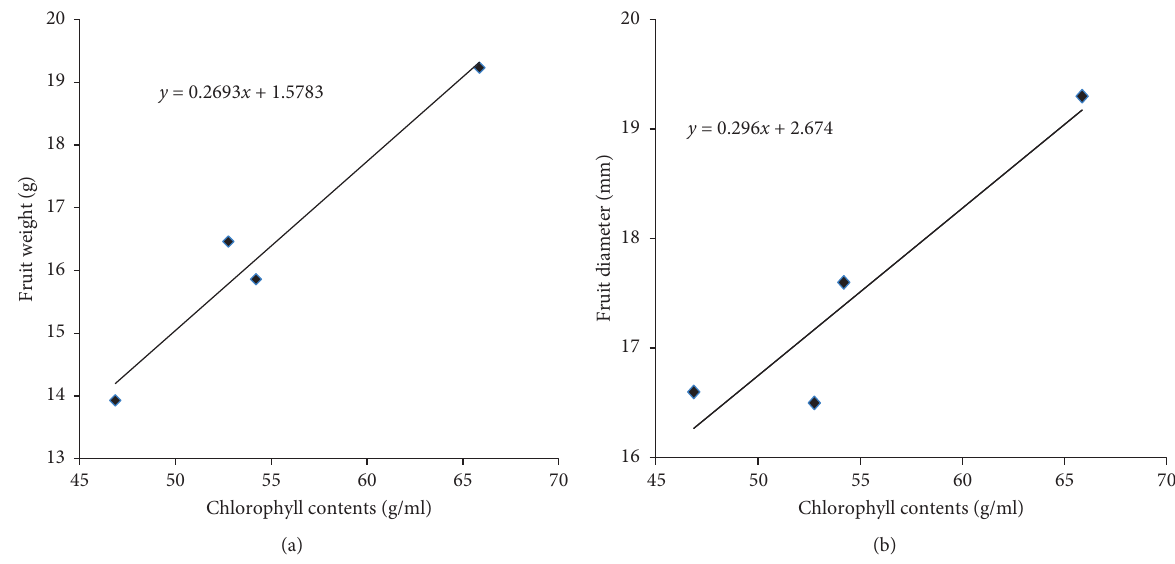
Figure 4: Relationship between chlorophyll contents: (a) fruit weight and (b) fruit diameter of strawberry cv. Chandler at P < 0 . 05.